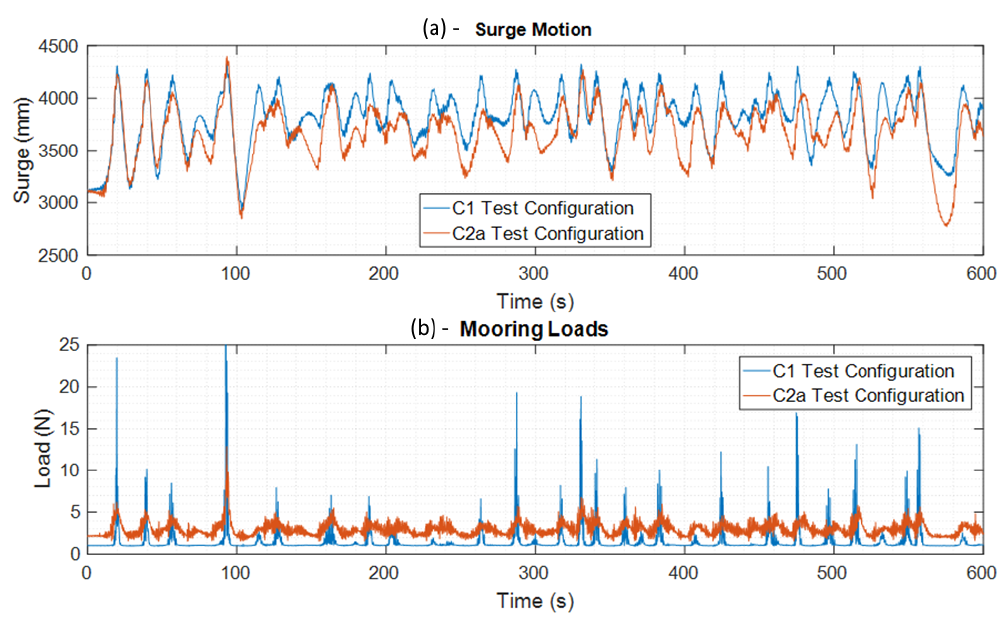
Figure 16. Surge ( a ) and mooring loads ( b ) time series for the two mooring configuration tests in the irregular wave